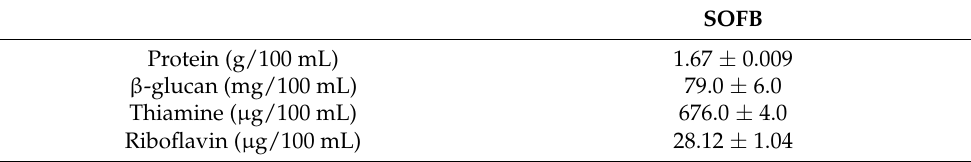
Table 3. Contents of protein, β -glucan, thiamine and riboflavin in